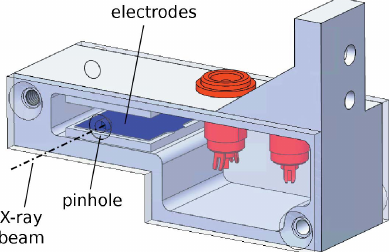
Figure 4 A rendering of the ion chamber. Parallel plate electrodes (blue), a recess for mounting a pinhole (identical recesses are found on both the incoming and outgoing sides) and the outgoing X-ray beam are marked. The electrical connectors are in red and the internal cabling is omitted.